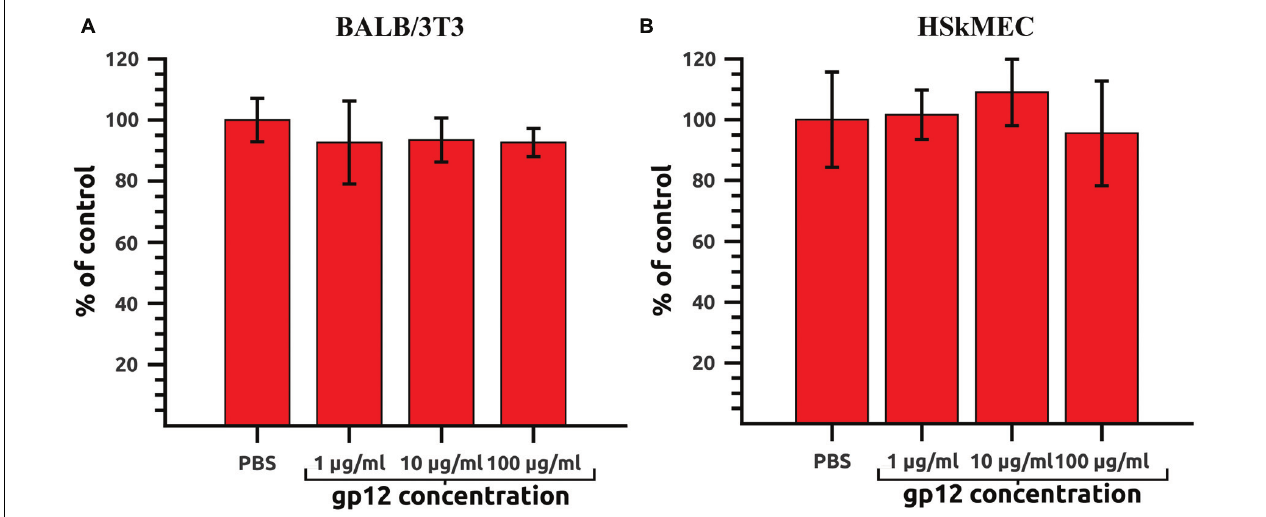
FIGURE 3 | Proliferation of gp12-treated mammalian cells in vitro . (A) Murine fibroblasts (BALB/3T3) treated with 1, 10, or 100 µ g/ml of gp12 for 72 h. PBS served as a control. (B) Human skin microvascular endothelial cells (HSkMEC) treated with 1, 10, or 100 µ g/ml of gp12 for 72 h. PBS served as a